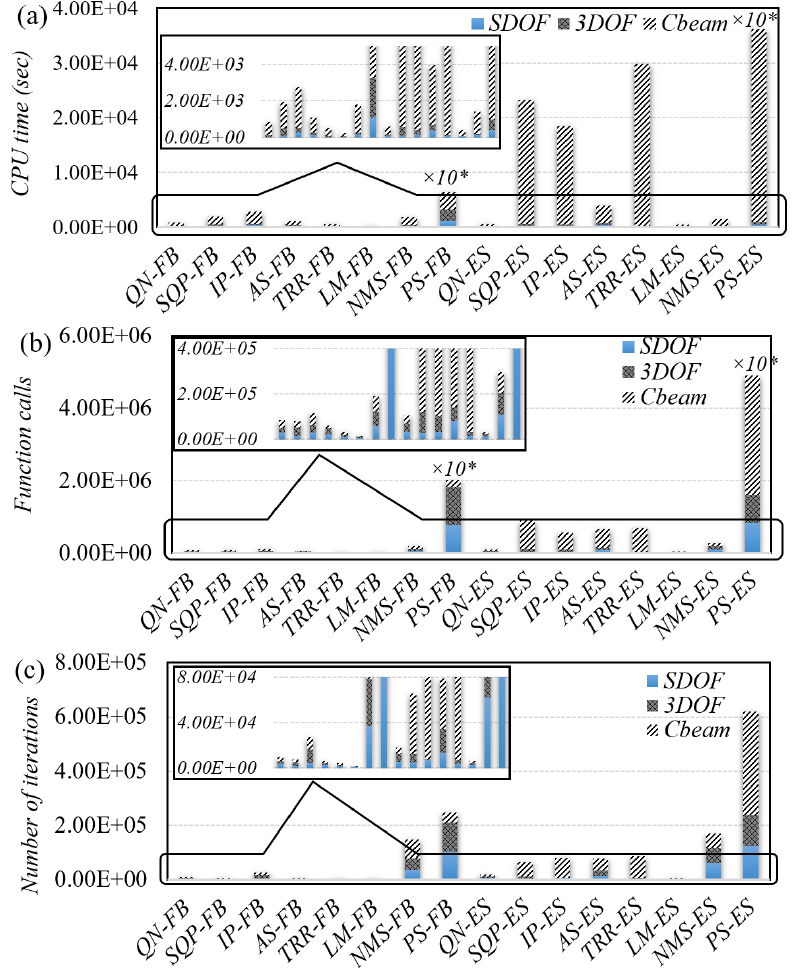
Figure 5. Efficiency criteria of optimisation methods for nonlinear model selection ( a ) CPU time, ( b ) function calls, ( c ) number of iterations; (*: the number of vertical axes should be multiplied by